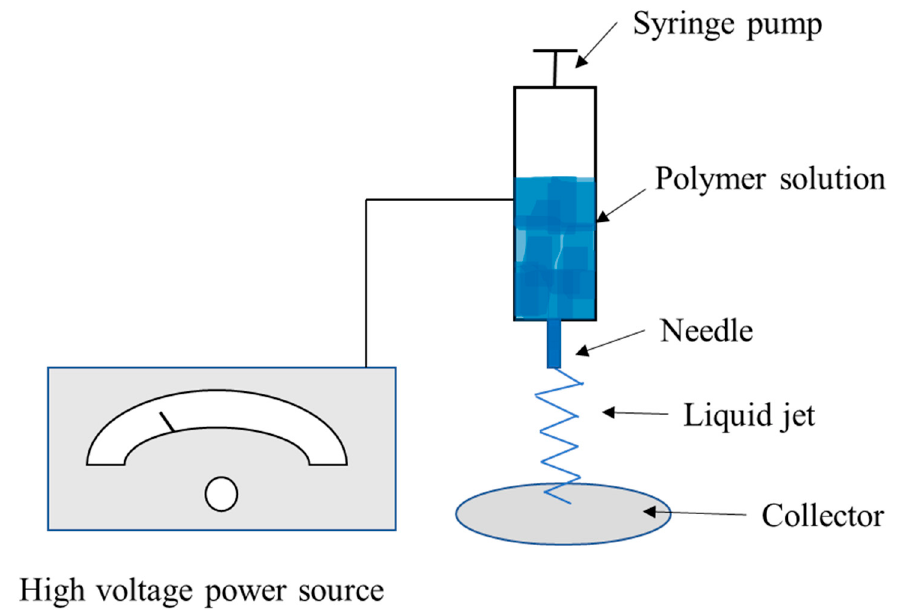
Figure 3. Diagram of the electrospinning method.